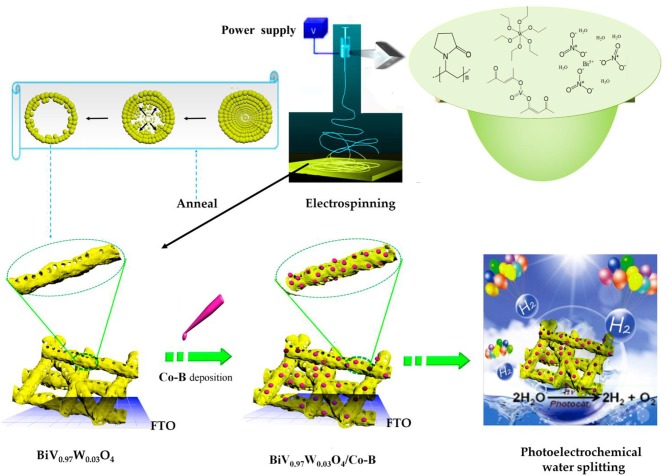
Schematic illustration of BiV0.97W0.03O4/Co-B nanotube fabrication process.